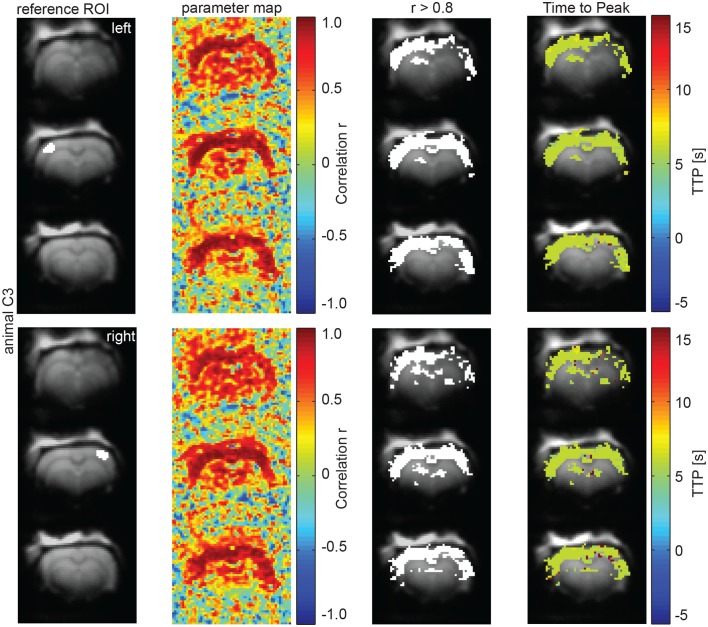
Calcium recordings-informed correlation analysis reveals pan-cortical BOLD activation during slow wave activity.ROIs on both hemispheres (ipsi- and contralateral sites of the fiber recordings), parameter maps showing r-values and regions of highest correlation (r > 0.8; white). The mean HR was calculated from these thresholded regions and time to peak of voxel-by-voxel HR was determined (same analysis as in main Figure 6C,D in different animal).